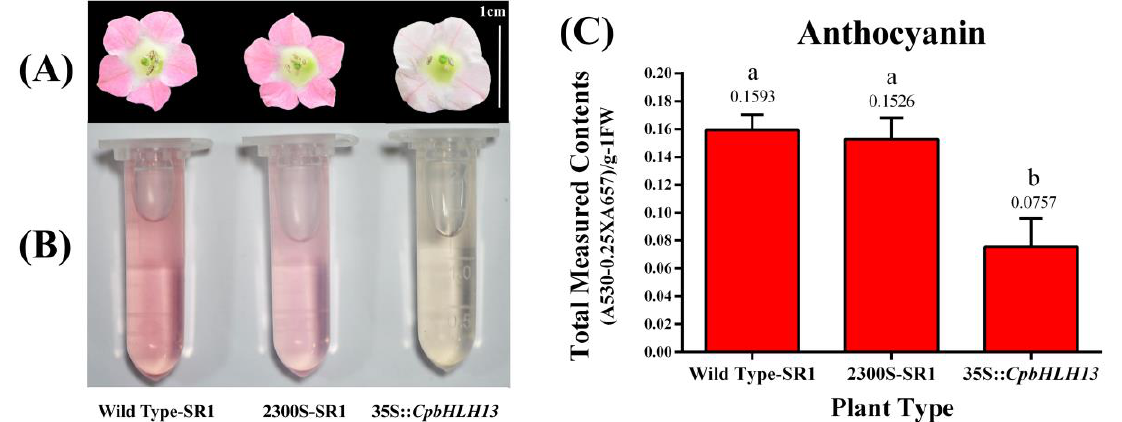
Figure 12. Anthocyanin accumulation from the flowers of ( A ) overexpressed CpbHLH13 tobacco plants (35S: CpbHLH13 ), wild type tobacco SR1 (Wild Type-SR1), and tobacco plants transformed by the empty vector pCAMBIA2300S (2300S-SR1). ( B ) Anthocyanin detection from the described plants. ( C ) Quantitative anthocyanin concentration in tobacco plants. Scale bar = 1 cm. The different letters on the bars show significance between the treatments by using least significant di ff erence (LSD) at p <